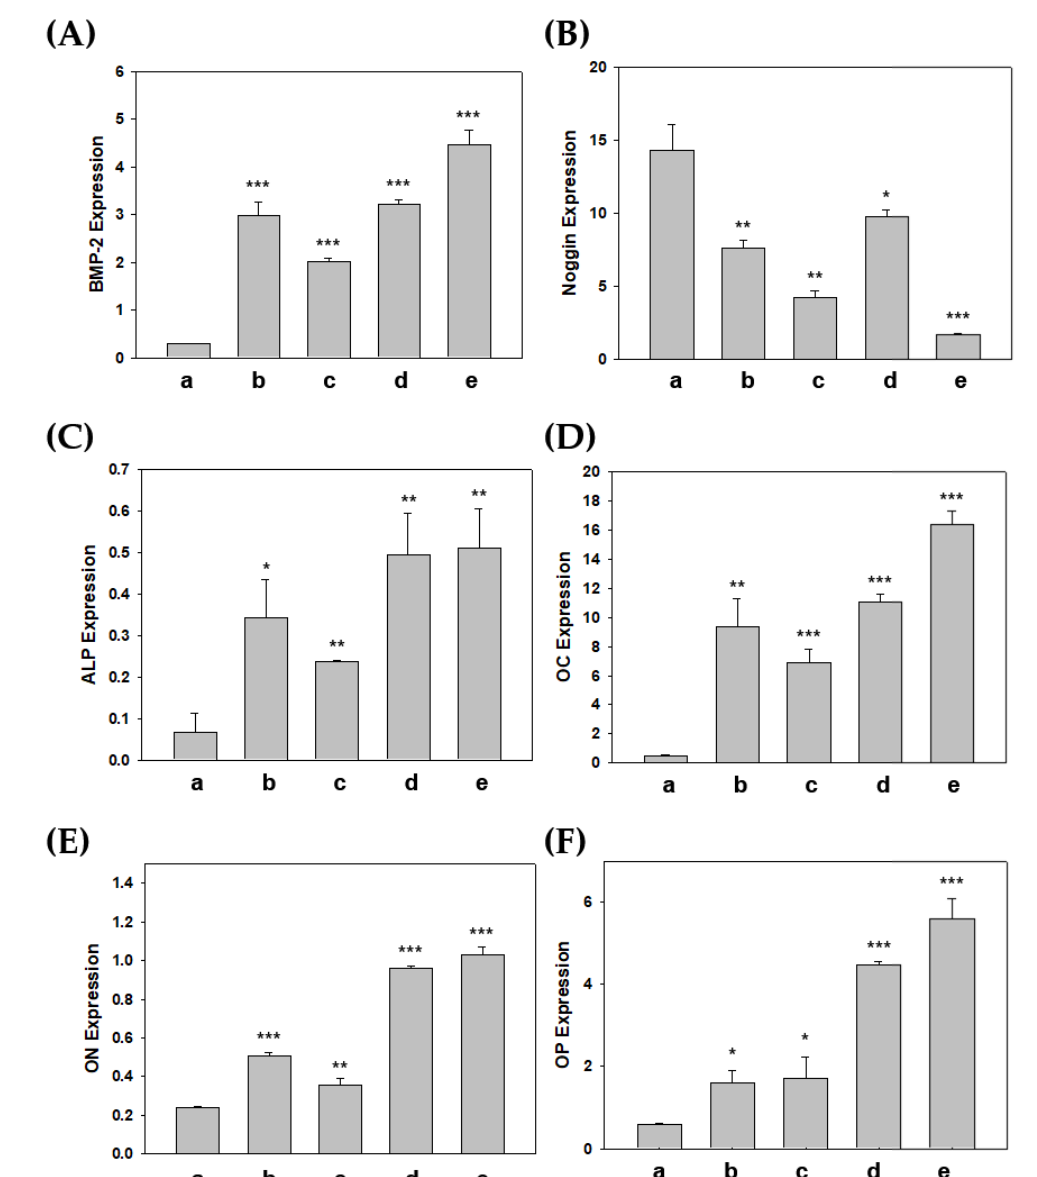
Figure 5. Expression profiles of ( A ) BMP-2 and ( B ) Noggin in hMSCs after transfection. Expression levels of osteogenic differentiation markers, including ( C ) alkaline phosphatase (ALP), ( D ) osteocalcin (OC), ( E ) osteonectin (ON), and ( F ) osteopontin (OP), were analyzed by quantitative RT-PCR. Experiments were carried out in duplicate and expressed as a mean ± SD. a. untreated; b. CaP/pBMP-2+mir148b; c. dopa-HA/CaP/mir148b; d. dopa-HA/CaP/pBMP-2; e. dopa-HA/CaP/pBMP+mir148b. Statistical difference between a test group and untreated control (a) was tested using Student’s t -test. * p < 0.05, ** p < 0.01, *** p < 0.001.